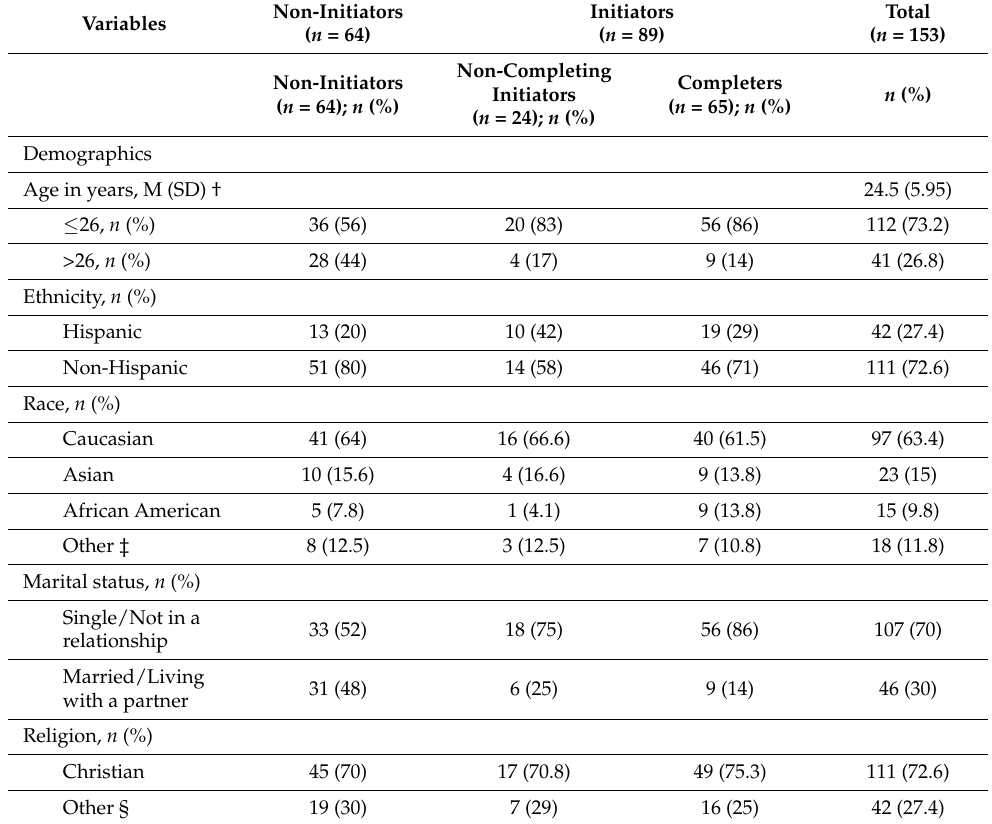
Table 1. Sample characteristics by HPV vaccination status among student nurses ( n =